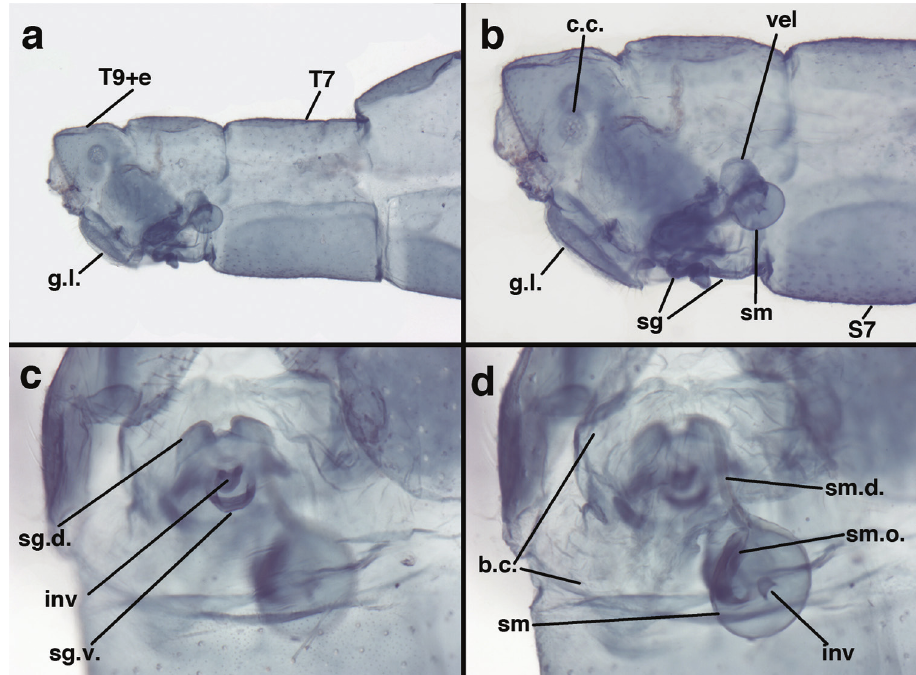
Figure 63. Ungla mexicana Tauber, sp. n. Female abdomen, ( a ) segments A7-terminus, lateral ( b ) terminalia, lateral ( c, d ) genitalia, ventral. b.c. bursa copulatrix c.c. callus cerci g.l. gonapophysis later- alis inv spermathecal invagination sg subgenitale sg.d . dorsal lobe of subgenitale sg.v. ventral lobe of subgenitale sm spermatheca sm.d. spermathecal duct sm.o . spermathecal opening to bursa copulatrix S7 seventh sternite T7 seventh tergite T9+e fused ninth tergite and ectoproct vel spermathecal velum (Mexico, Chiapas, holotype, CAS) .